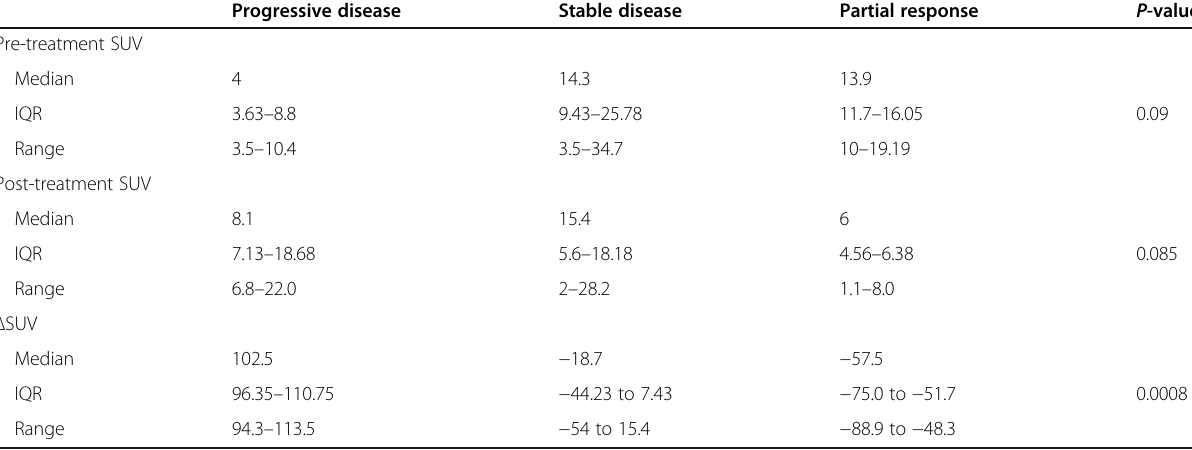
Table 6 Comparison between pre-treatment SUV, post-treatment SUV, and % change in SUV ( Δ SUV) of the PD, SD, and PR groups Progressive disease Stable